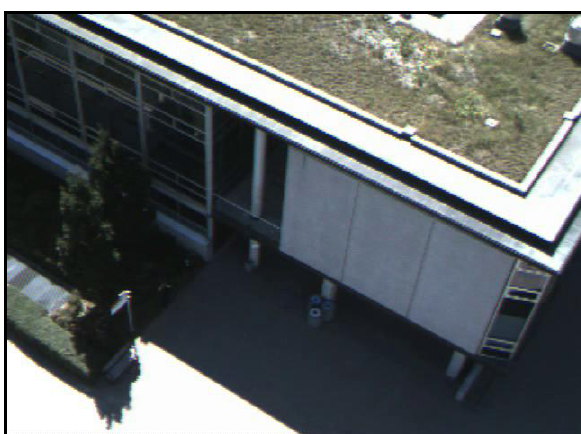
Figure 6. Sample synthetic image Line matching approaches divide into algorithms that match individual line segments, and algorithms that match groups of line segments. Matching single lines is based on geometric properties, such as orientation, length, and extent of